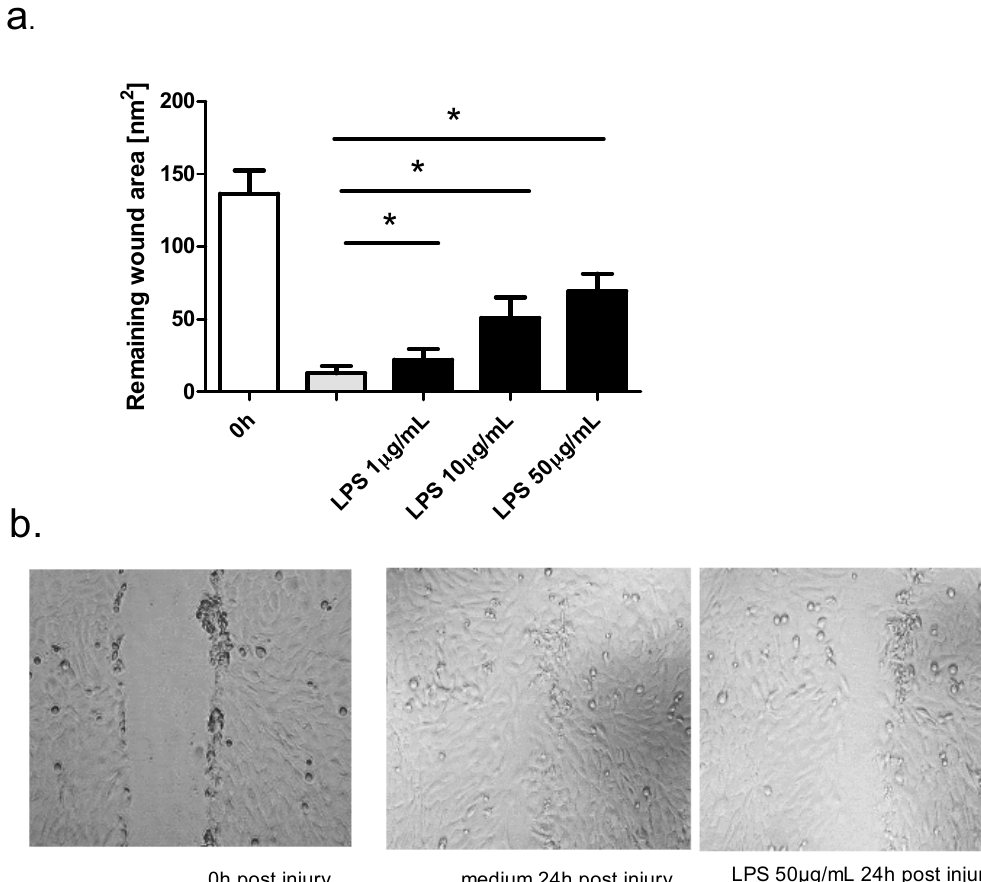
Figure 3. Effect of the toll-like receptor (TLR) agonist LPS on wound repair in BEAS-2B ( n = 8), 24 h post injury. ( a ) Concentration dependent effect of LPS on wound repair in BEAS-B cultures, remaining wound area was measured 24 h post injury 2; ( b ) Representative images of injured BEAS-2B cells 0 h and 24 h post injury with or without LPS (50 μ g/mL). NS, no statistically significant difference. The magnification is 100×; * p < 0.05 .